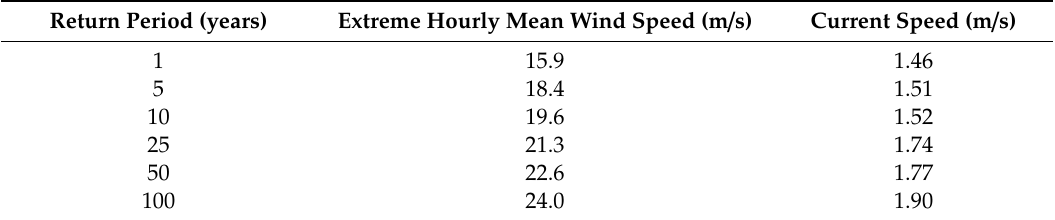
Table 3. Characteristic wind and water current speeds at selected